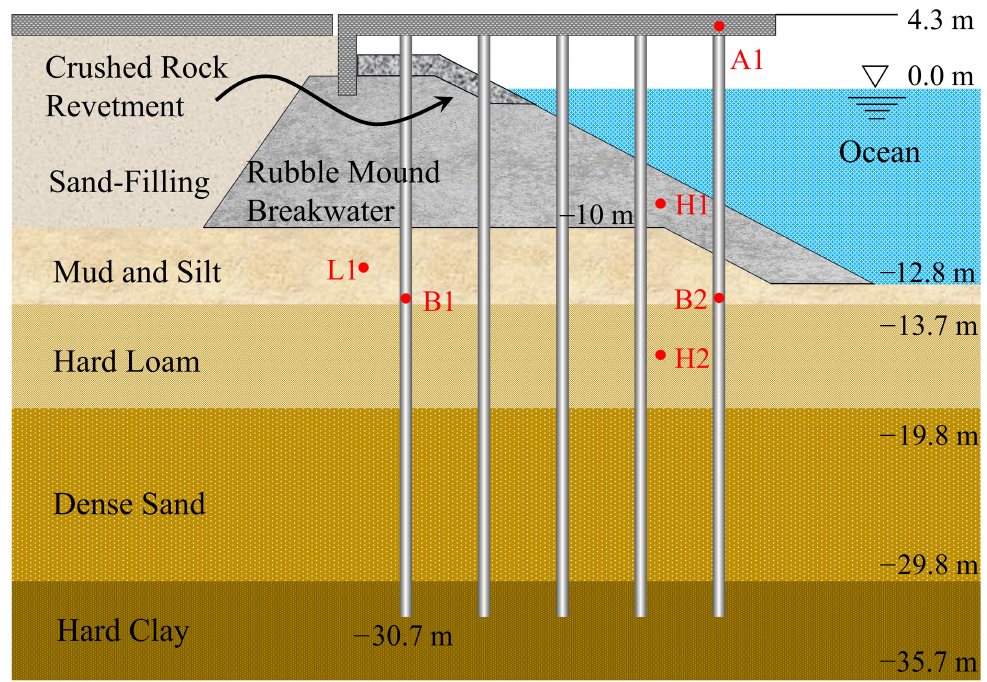
Figure 2. The numerical model.